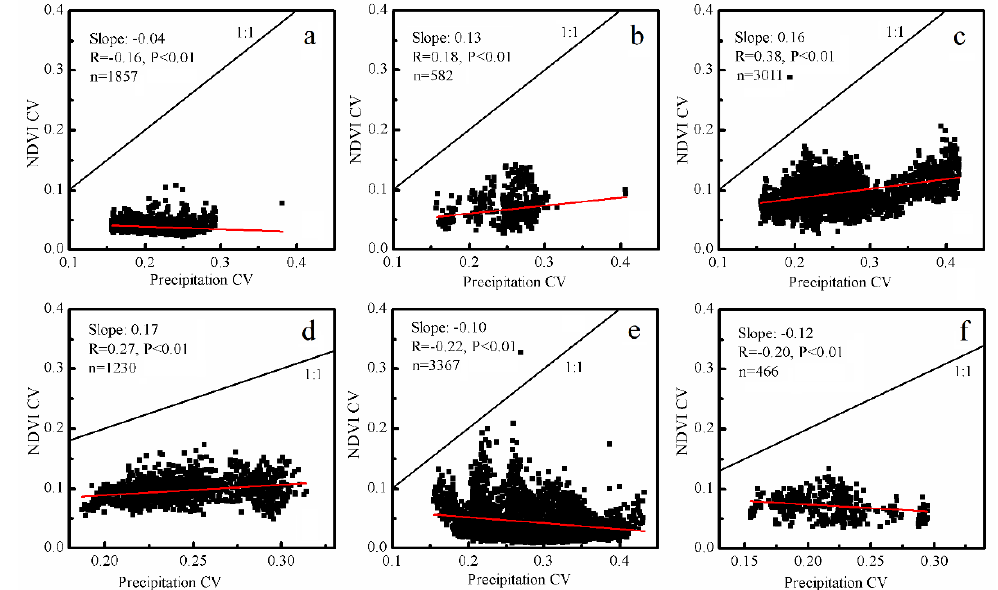
Figure 7. Relationships between the CVs of the growing season precipitation and those of the NDVI in Inner Mongolia during 1982–2015: ( a ) forest, ( b ) meadow steppe, ( c ) typical steppe, ( d ) desert steppe, ( e ) desert, and ( f ) crop.